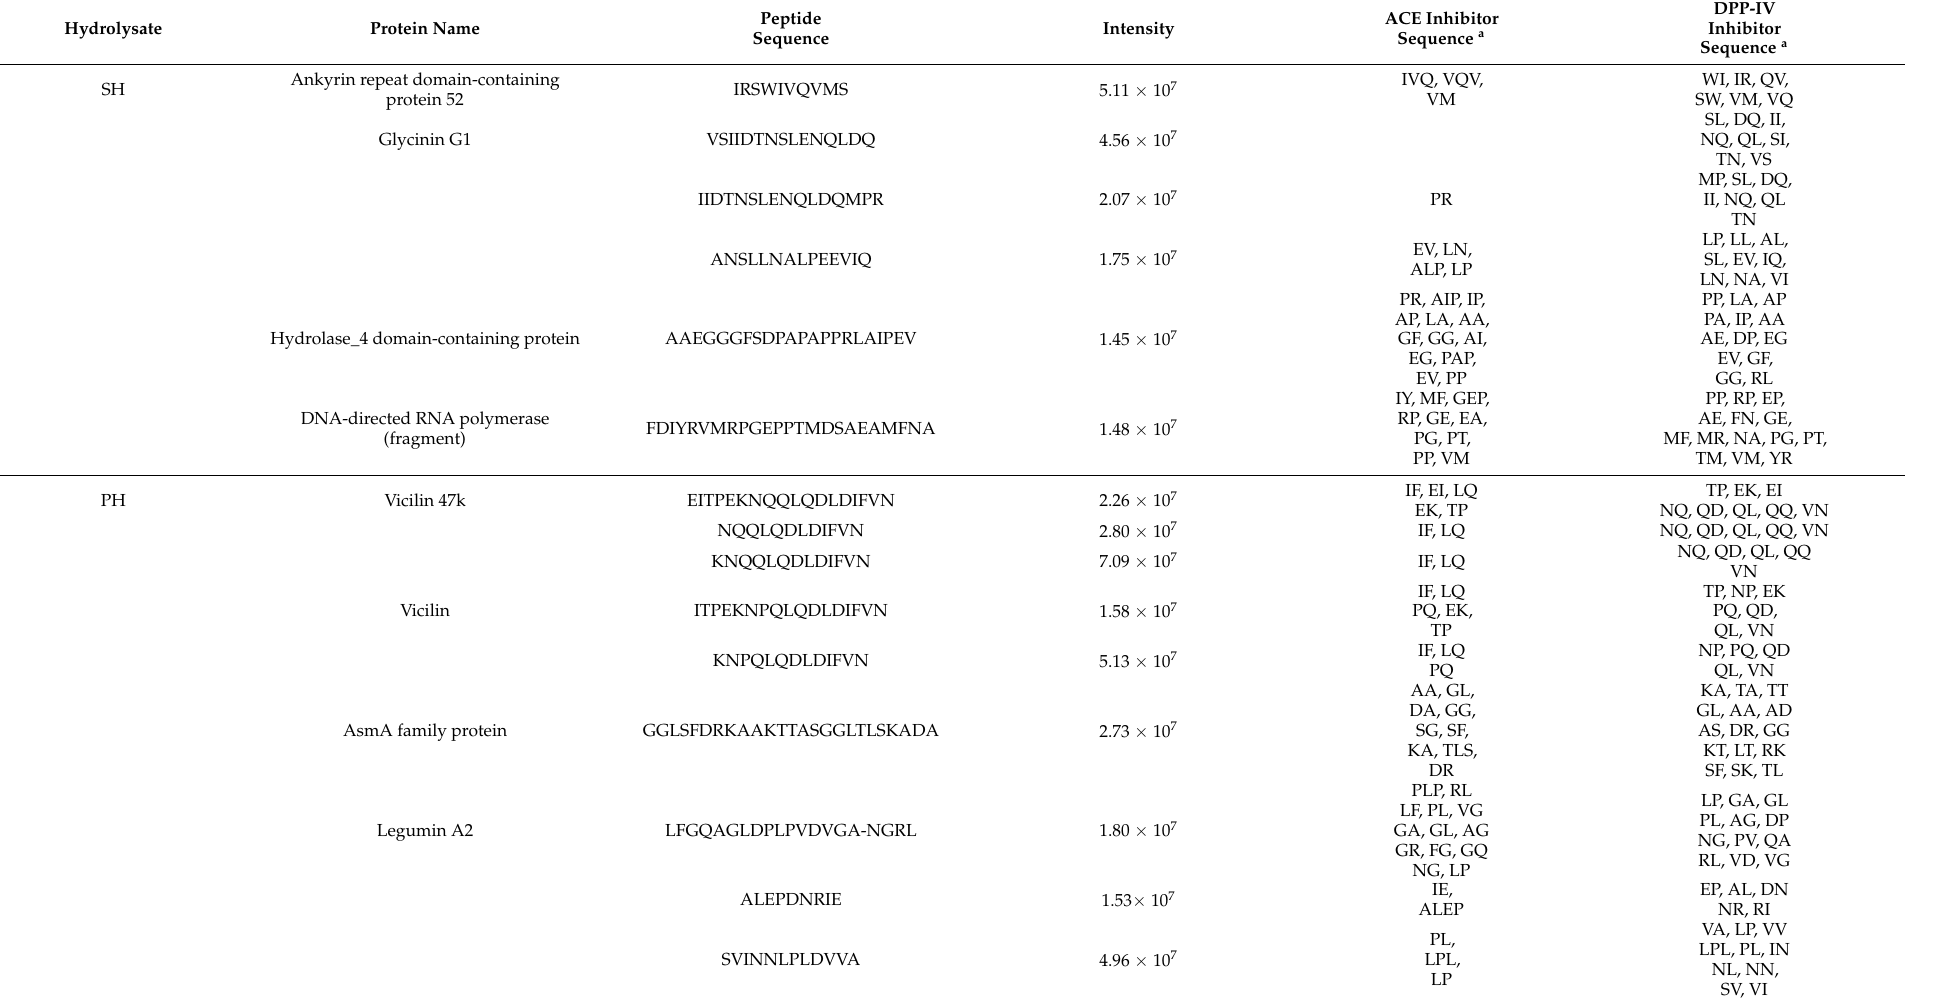
Table 2. SH and PH peptides from the most abundant protein, with ACE and DPP-IV inhibitory